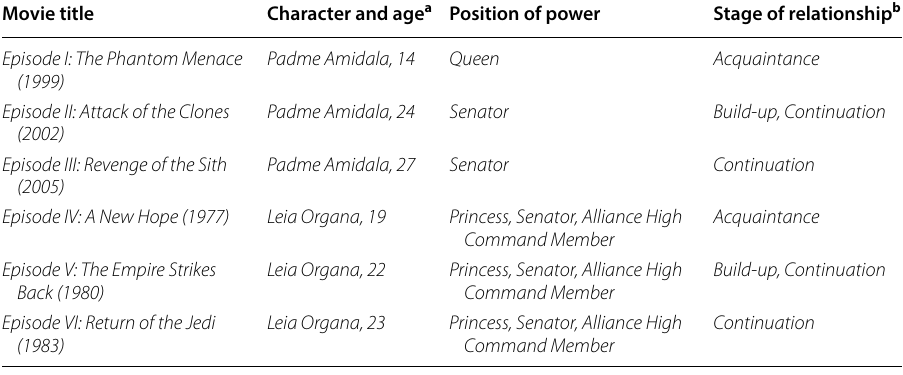
Table 1 Star Wars